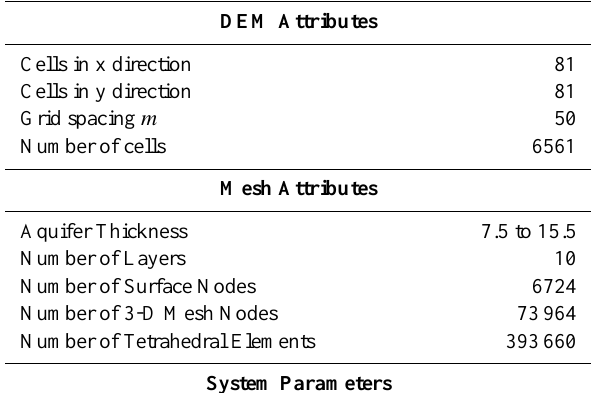
Table 1. Frequency distribution of the ensemble of perturbed values for the observed WT value of 18.5 m collected on day 91 at location (X=2500 m, Y=3500m) of the “true aquifer”, for CV values of 0.10 and